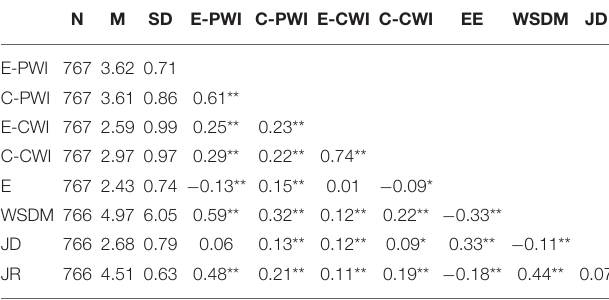
TABLE 1 | Bivariate correlations (r), N , mean ( M ), and standard deviation ( SD ) statistics for all variables included in the mediation analyses: Emotional (E-) and cognitive (C-) component of personal work-identity (PWI); emotional (E-) and cognitive (C-) component of collective work-identity (CWI); exhaustion (E); work self-determined motivation (WSDM); psychological job demands (JD); and psychological job resources